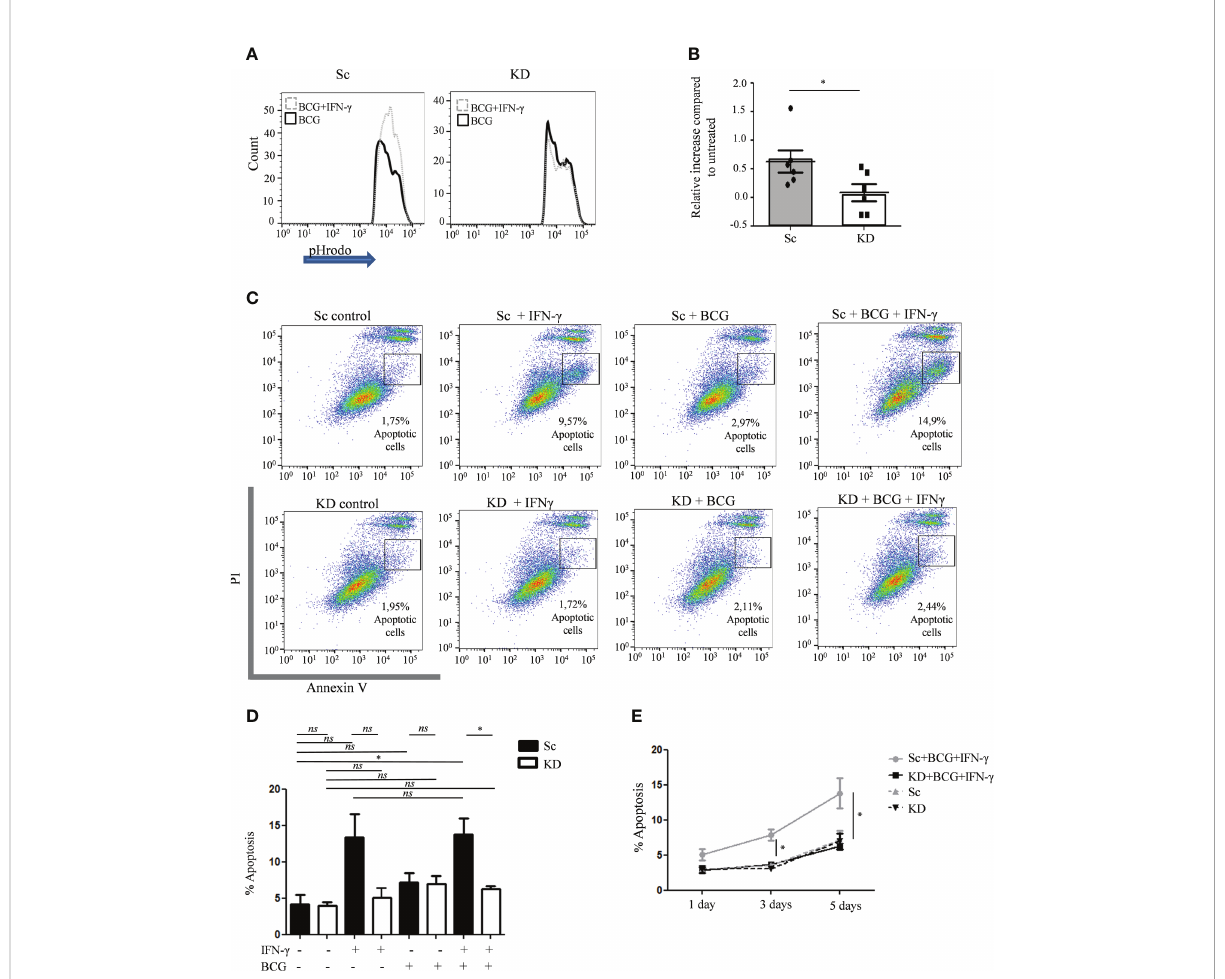
FIGURE 3 Phagosome acidi fi cation and apoptosis is reduced in JAK1-de fi cient THP-1 cells. (A, B) FC measurement of phagosome acidi fi cation using detection of pHrodo-labelled BCG post infection of THP-1 cells, with or without prior IFN- g stimulation. Data is from six independent experiments. (C – E) Percentage of apoptosis quanti fi ed by FC using annexin V/PI staining in THP-1 cells at different time points following BCG infection, with or without IFN- g stimulation. C displays a representative experiment 5 days post infection. D and E are from four independent experiments, showing 5 day (D) and 1, 3 and 5 day (E) timepoints. Statistical comparisons in E are for Sc+BCG+IFN vs . KD+BCG+IFN. Two-tailed Mann Whitney test. *P <0.05; NS, not signi fi